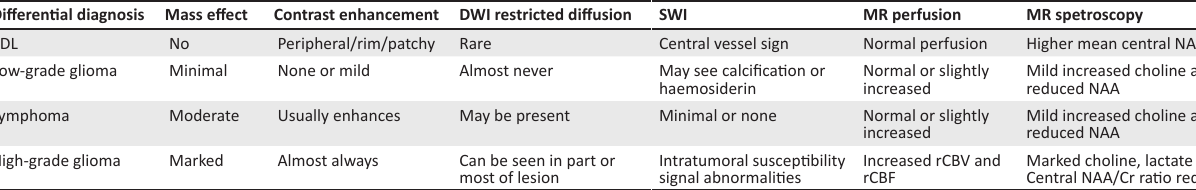
TABLE 1: Differentiating TDL from glioma and lymphoma. Differential diagnosis Mass effect